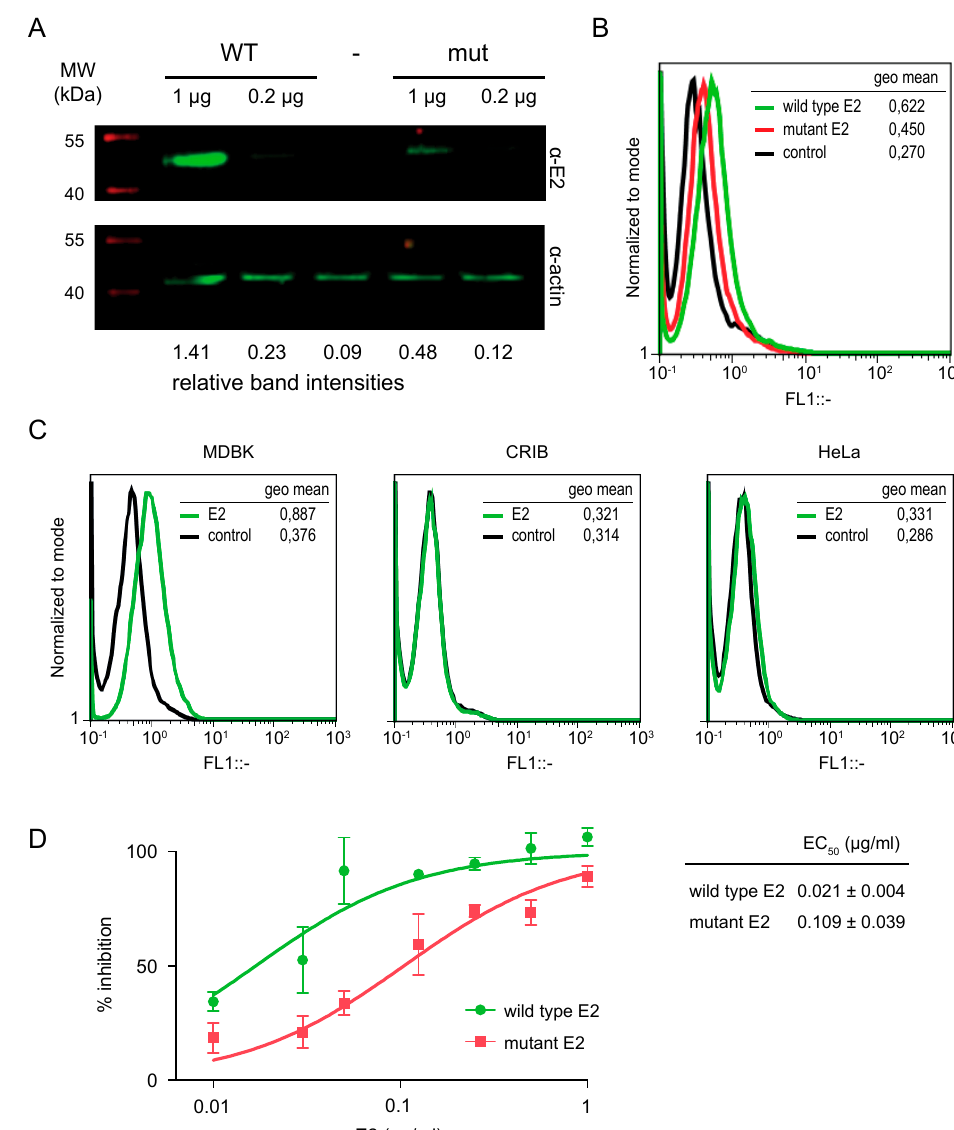
Figure 3. Mutation of the exposed β -hairpin motif impairs E2 function. ( A , B ) Binding of wild type and mutant E2 soluble form to the surface of BVDV susceptible MDBK cells detected by Western blot and flow cytometry. ( A ) Western Blot. Bound E2 was detected in cell lysates resolved by SDS-PAGE using an anti E2 polyclonal antibody. Actin was used as a loading control. Relative band intensities are indicated for each lane. The gel is representative of three independent experiments. ( B ) Flow cytometry. Bound E2 was detected by surface staining of fixed samples with a polyclonal antibody against E2. Histogram of relative fluorescence intensity (FL1) for control cells (control, black line), and cells treated with wild type (green line) or mutant (red line) E2. The histogram is representative of two independent experiments. ( C ) Specificity of binding. Binding of wild type soluble form of E2 to the surface of MDBK cells and non-susceptible CRIB and HeLa cells detected by flow cytometry. Histogram of relative fluorescence intensity (FL1) for control cells (control, black line), and cells treated with wild type E2 (green line). Fluorescence intensities recorded as the geometric mean of the cell population are presented. ( D ) Functionality of recombinant E2 tested in a cytopathic effect reduction assay. MDBK cells were preincubated with increasing amounts of the recombinant protein and then infected with cpBVDV at an MOI of 0.01. At 3 to 4 days postinfection, cells were fixed and stained with crystal violet to estimate the extent of the cytopathic effect. Plot of the log concentration versus the percentage of inhibition. Error bars represent the standard deviation of triplicates for each point. Inhibitory concentrations were estimated from nonlinear regression fitting of the curve with GraphPad Prism 5 software. EC 50 values are the mean and standard deviation from three independent experiments.